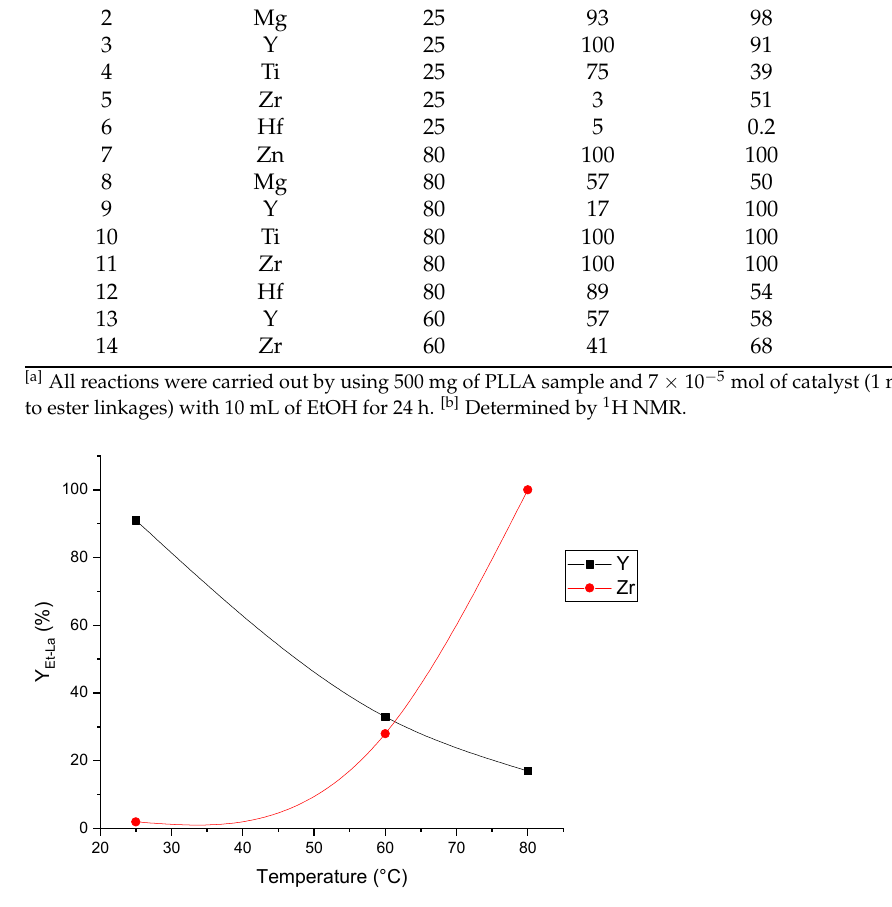
Figure 3. Yield of ethyl lactate by Zr and Y amides at different temperatures.